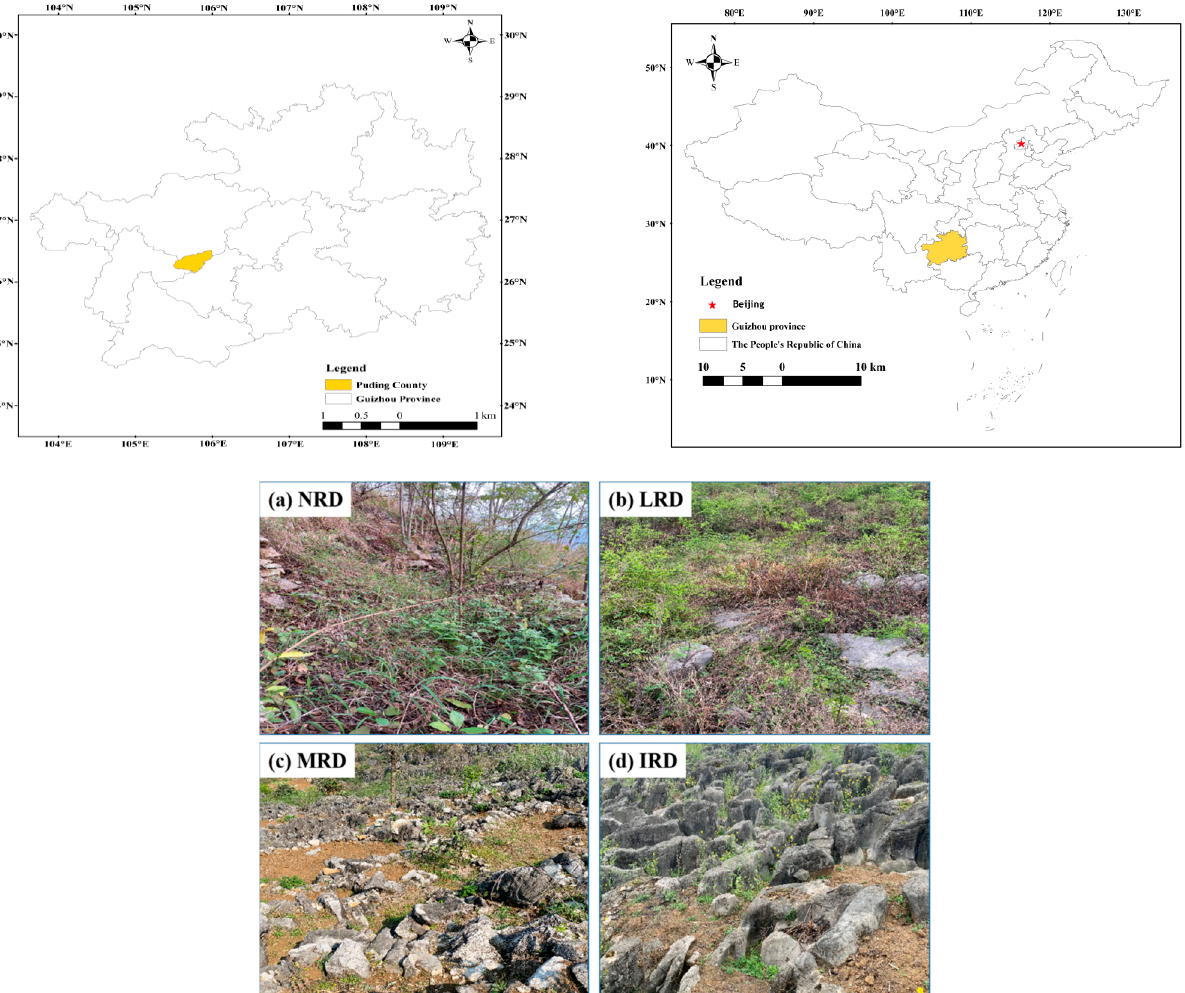
Figure 1. Location of the study area and sampling sites in Puding county, Guizhou province and the pictures of different rocky desertification grades in the study: ( a ) non rocky desertification (NRD), ( b ) light rocky desertification (LRD), ( c ) moderate rocky desertification (MRD) and ( d ) intense rocky desertification (IRD).